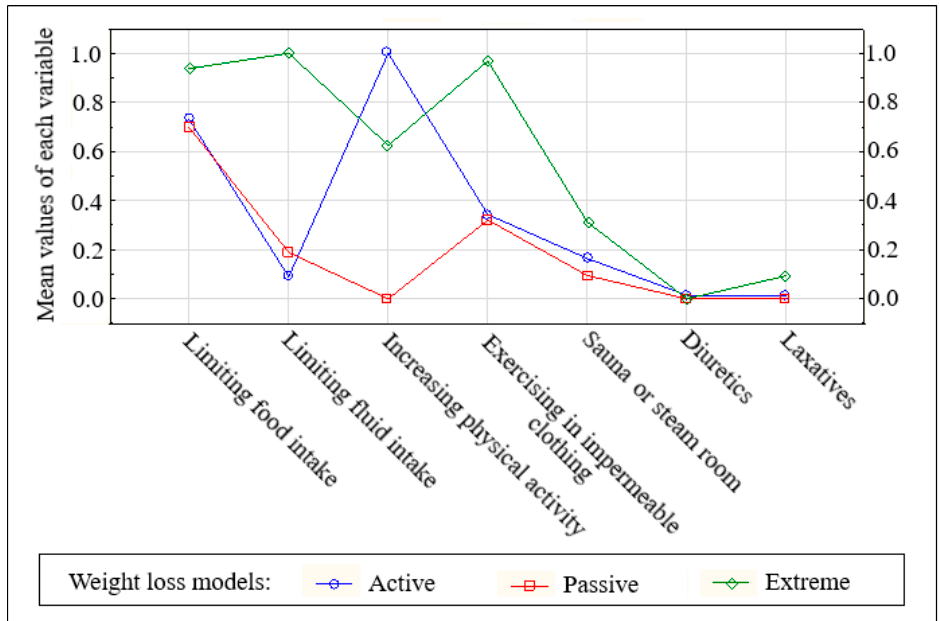
Figure 1. K-means clustering results-graph illustrating mean values of each variable (dimension) that discriminates the three weight loss models. Variables: use of weight loss methods (did not use = 0, used = 1). The supplementary Table S1 presents percentage of athletes using individual weight loss methods in the identified weight loss models.